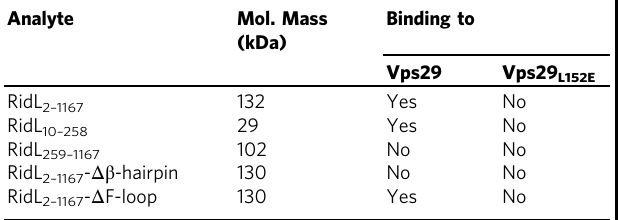
Table 2 SPR analysis of RidL – Vps29 interactions